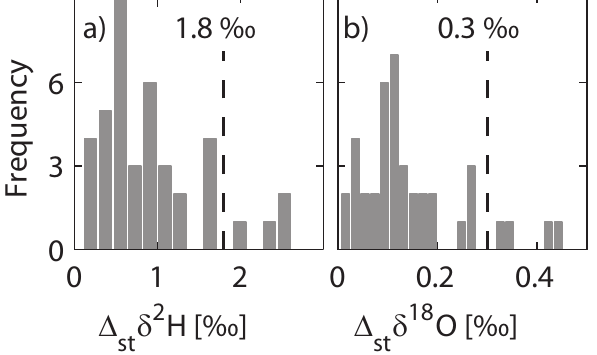
Fig. 4. Histograms for the maximum differences in δ 2 H (a) and δ 18 O (b) values among vials of the three stages collected by the CASCC ( ∆ st = max i,j =1 , 2 , 3 ( | δ i − δ j | ) ) for all cloud samples. The dashed line denotes the 90-percentile of the ∆ st distribution (1.8 ‰ or 0.3 ‰).